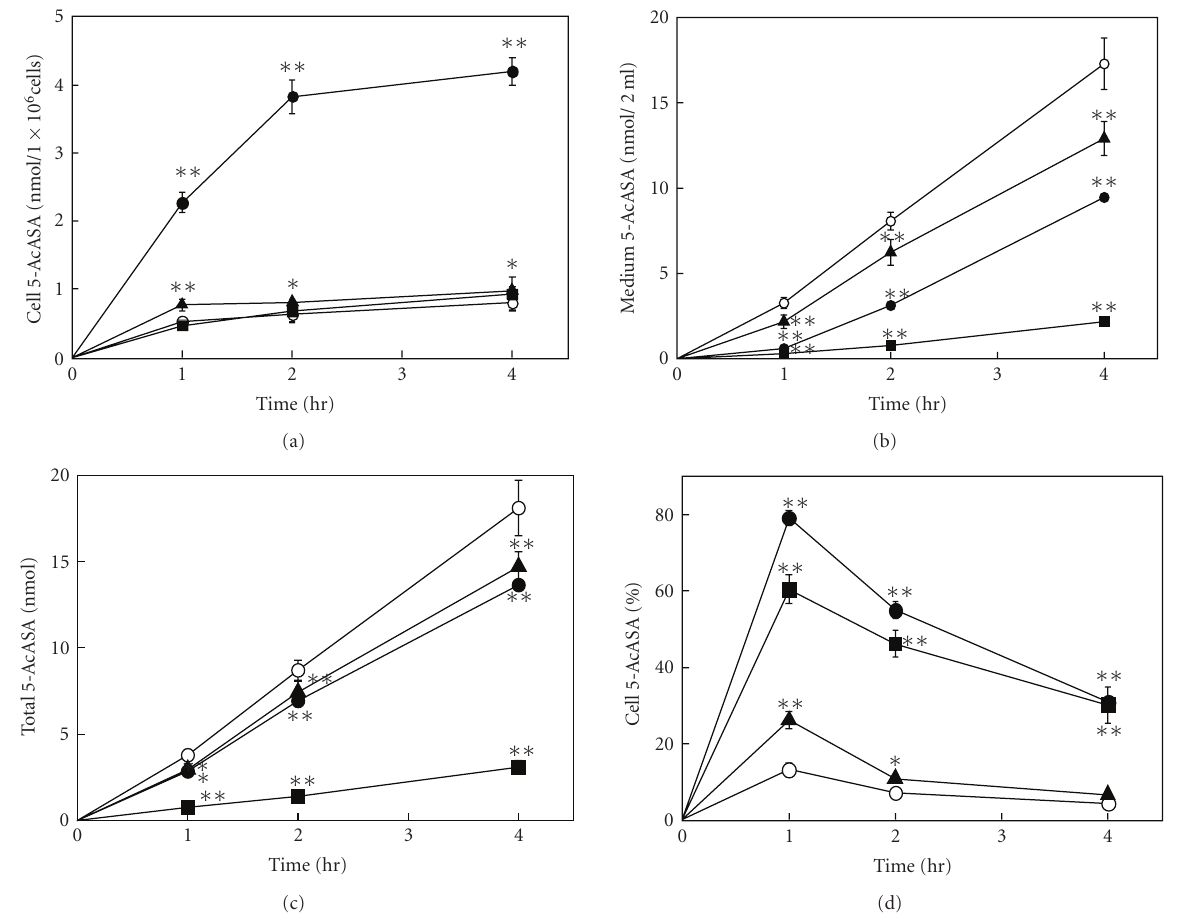
Figure 2: (a) The time course curve of N -acetyl 5-aminosalicylic acid in Caco-2 cells, (b) the medium and (c) the total, and (d) the cellular accumulation percent. Caco-2 cells grown in tissue culture dishes were incubated with 200 μ M 5-ASA for 1, 2, and 4 hours in the absence ( ) and the presence of quercetin ( ), fisetin ( ), and morin ( ) at the concentration of 100 μ M. Cell 5-AcASA (%): (cells/cells plus medium) × 100. Each point represents the mean ± SD of four to five experiments. Significant di ff erence from control ∗ P < . 05, ∗∗ P < .